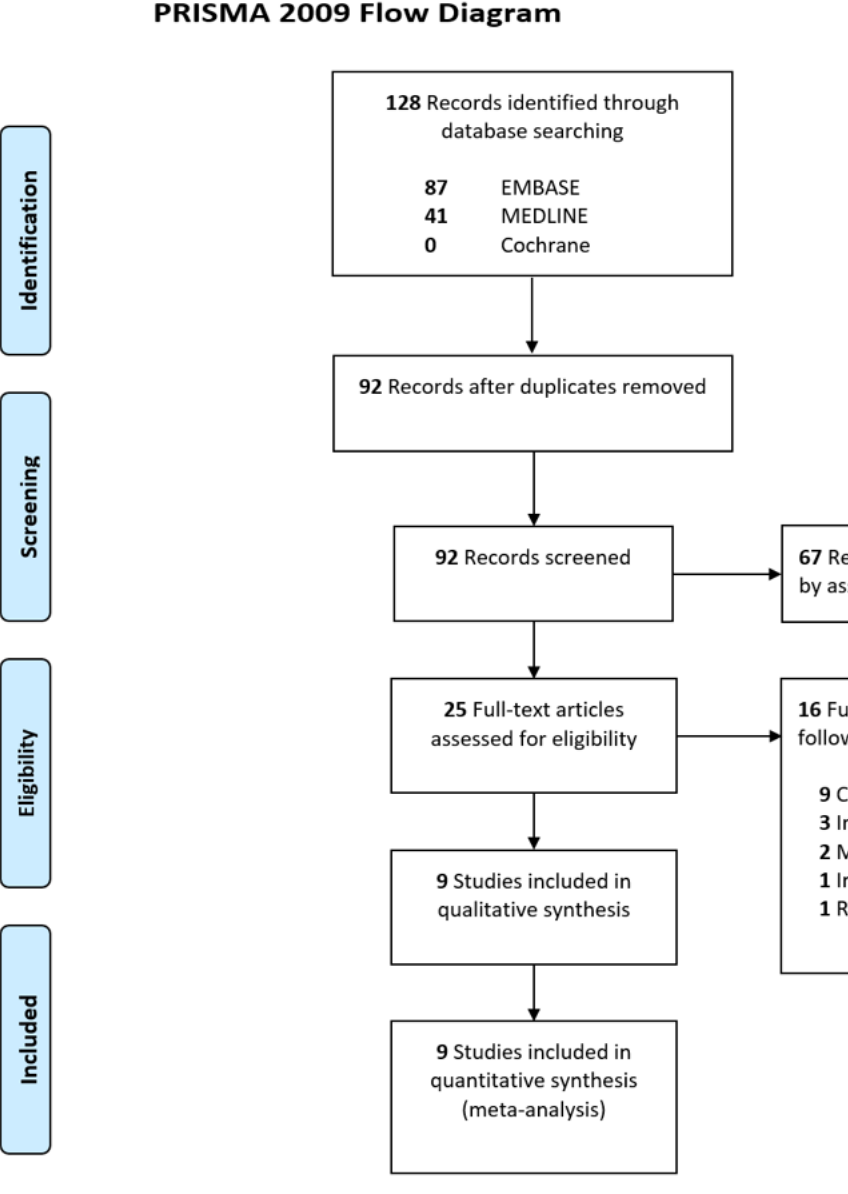
Figure 1. Flow diagram of studies included in the meta-analysis. Table 1. Study characteristics.